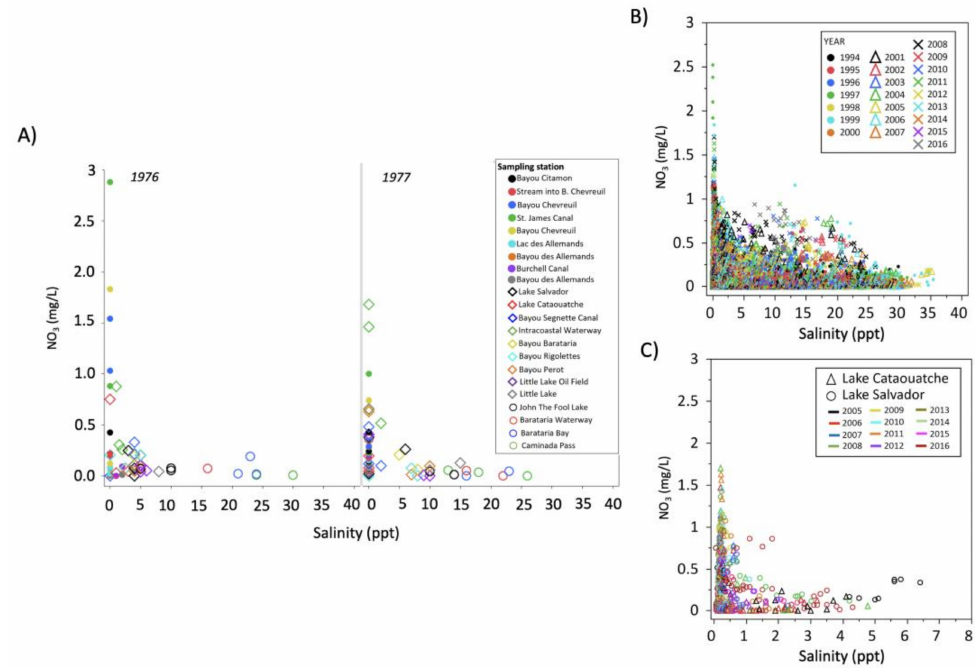
Figure 9. Mixing diagrams for inorganic nitrogen (NO x ) in the Barataria Basin. ( A ) Data from [46]; ( B ) data from [16]; ( C ) mixing diagram for stations added in 2005 in Lake Cataouatche and eastern Lake Salvador by [16] to reflect the impact of the Davis Pond diversion; notice the change in the X-axis range